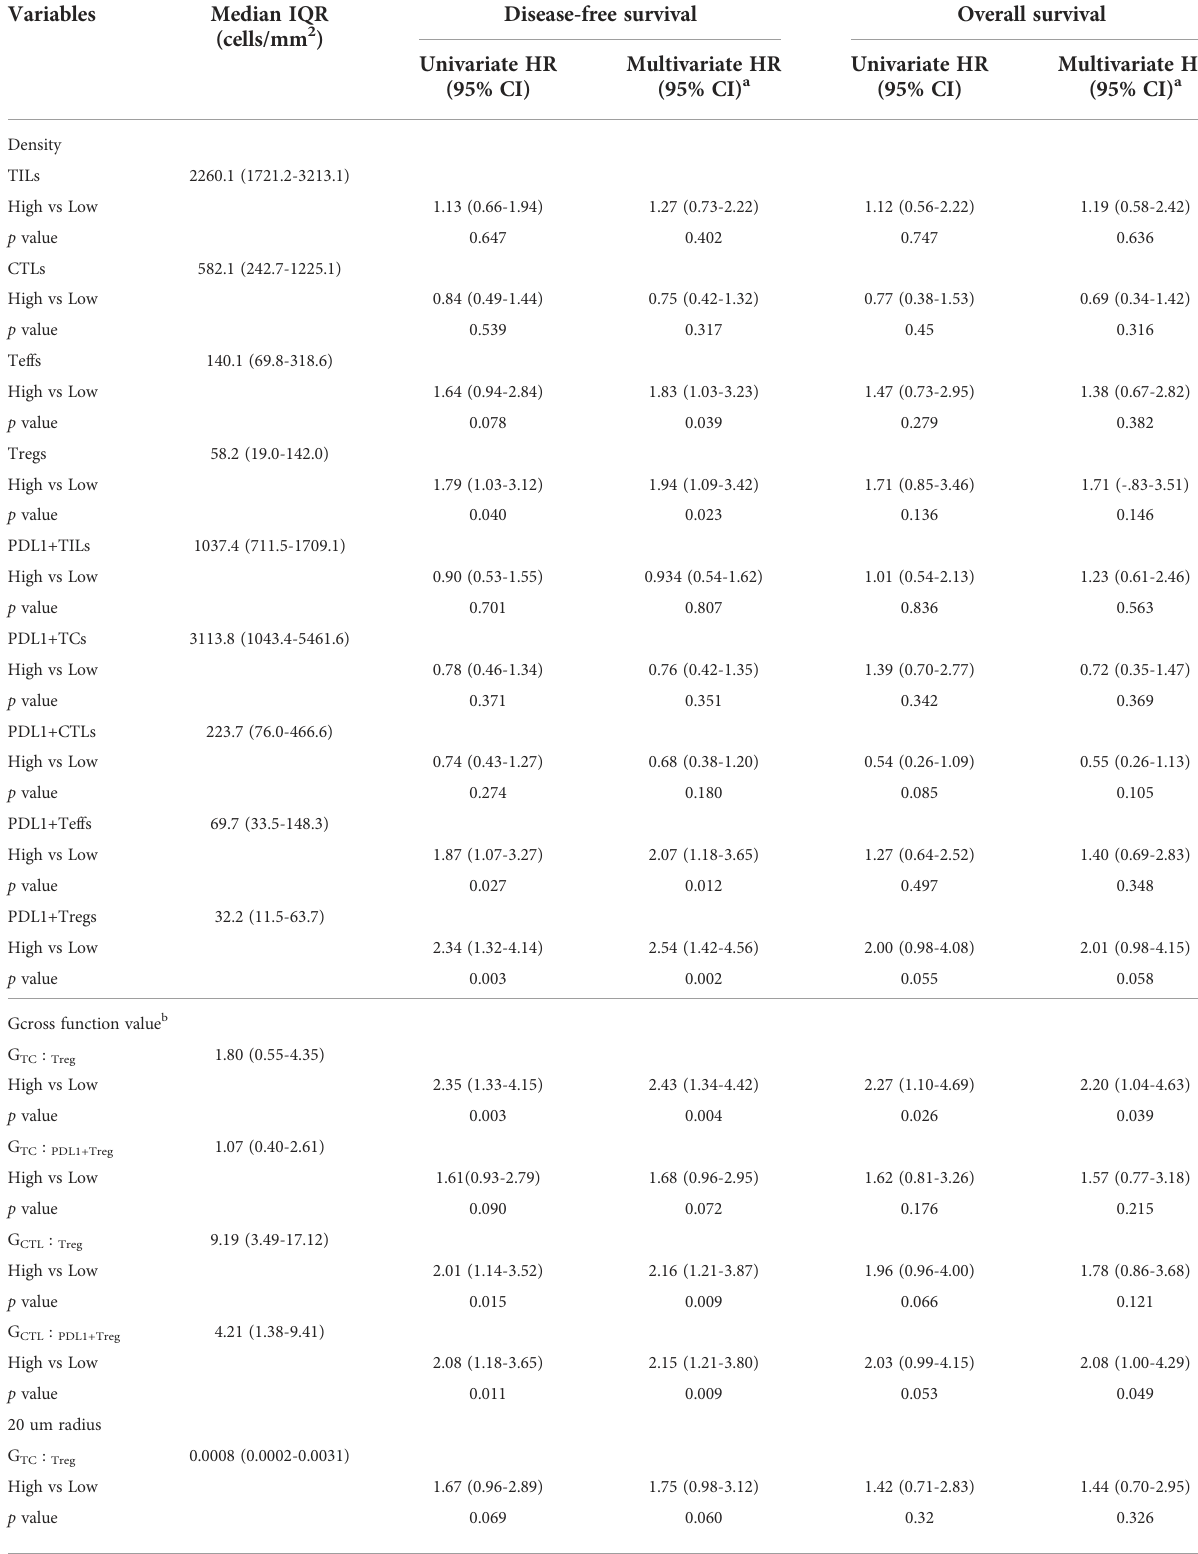
TABLE 2 Univariate and multivariate analysis for OS and DFS according to densities and Gcross functions of TILs